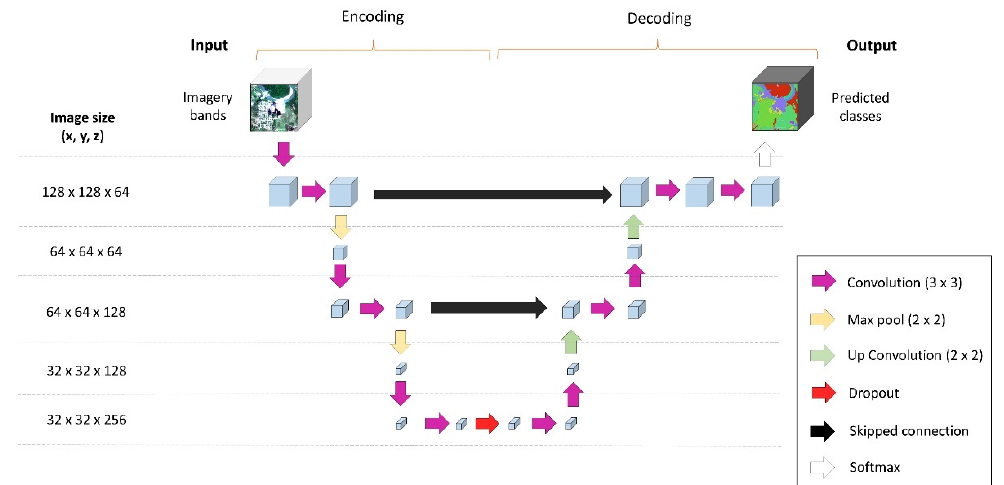
Figure 3. U-Net encoder/decoder architecture diagram. Image size (x, y, z) shows the dimensions of the images: width (x), height (y) and number of bands (z). This diagram shows a three hidden layer U-net, in which steps with the same number of bands correspond to a single hidden layer.